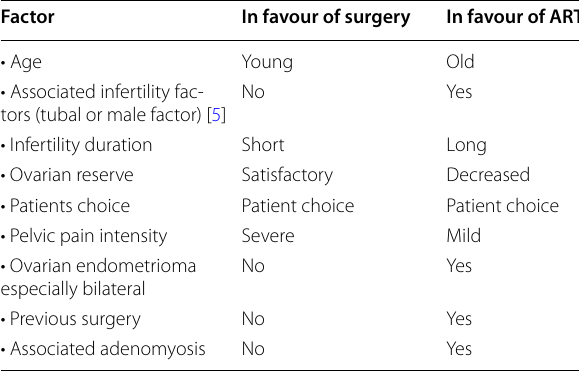
Table 1 Surgery vs ART in endometriosis [37] Factor In favour of surgery In favour of ART